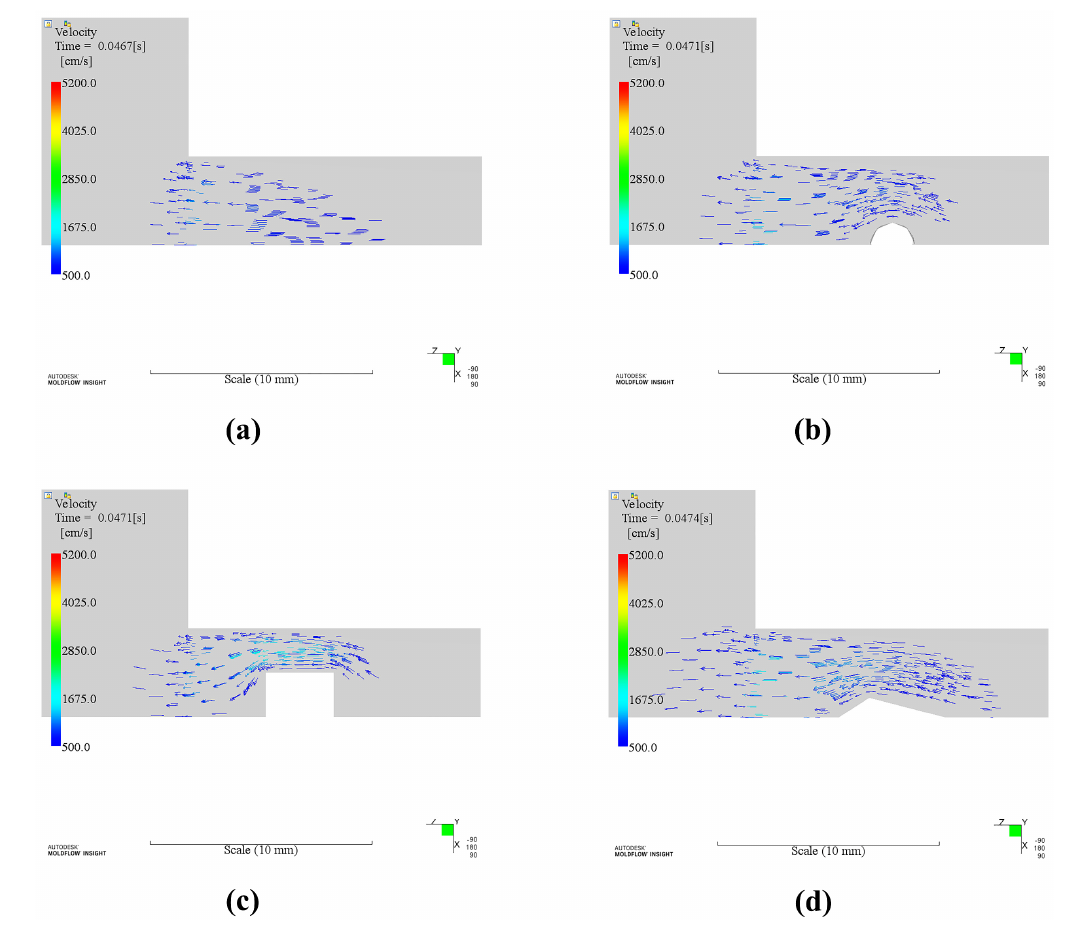
Figure 11. Velocity fields of different cases: ( a ). Without insert; ( b ). Circular insert; ( c ). Rectangular insert; ( d ). Diamond insert.